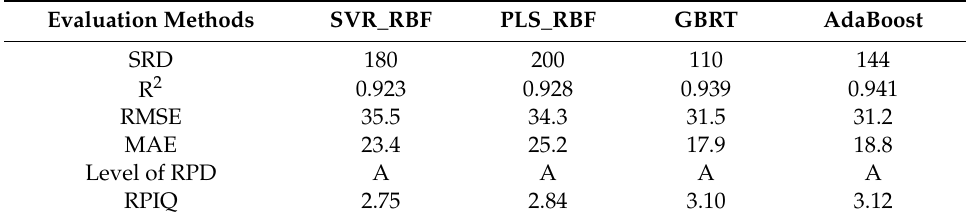
Table 9. Evaluation results of the regression models with the testing